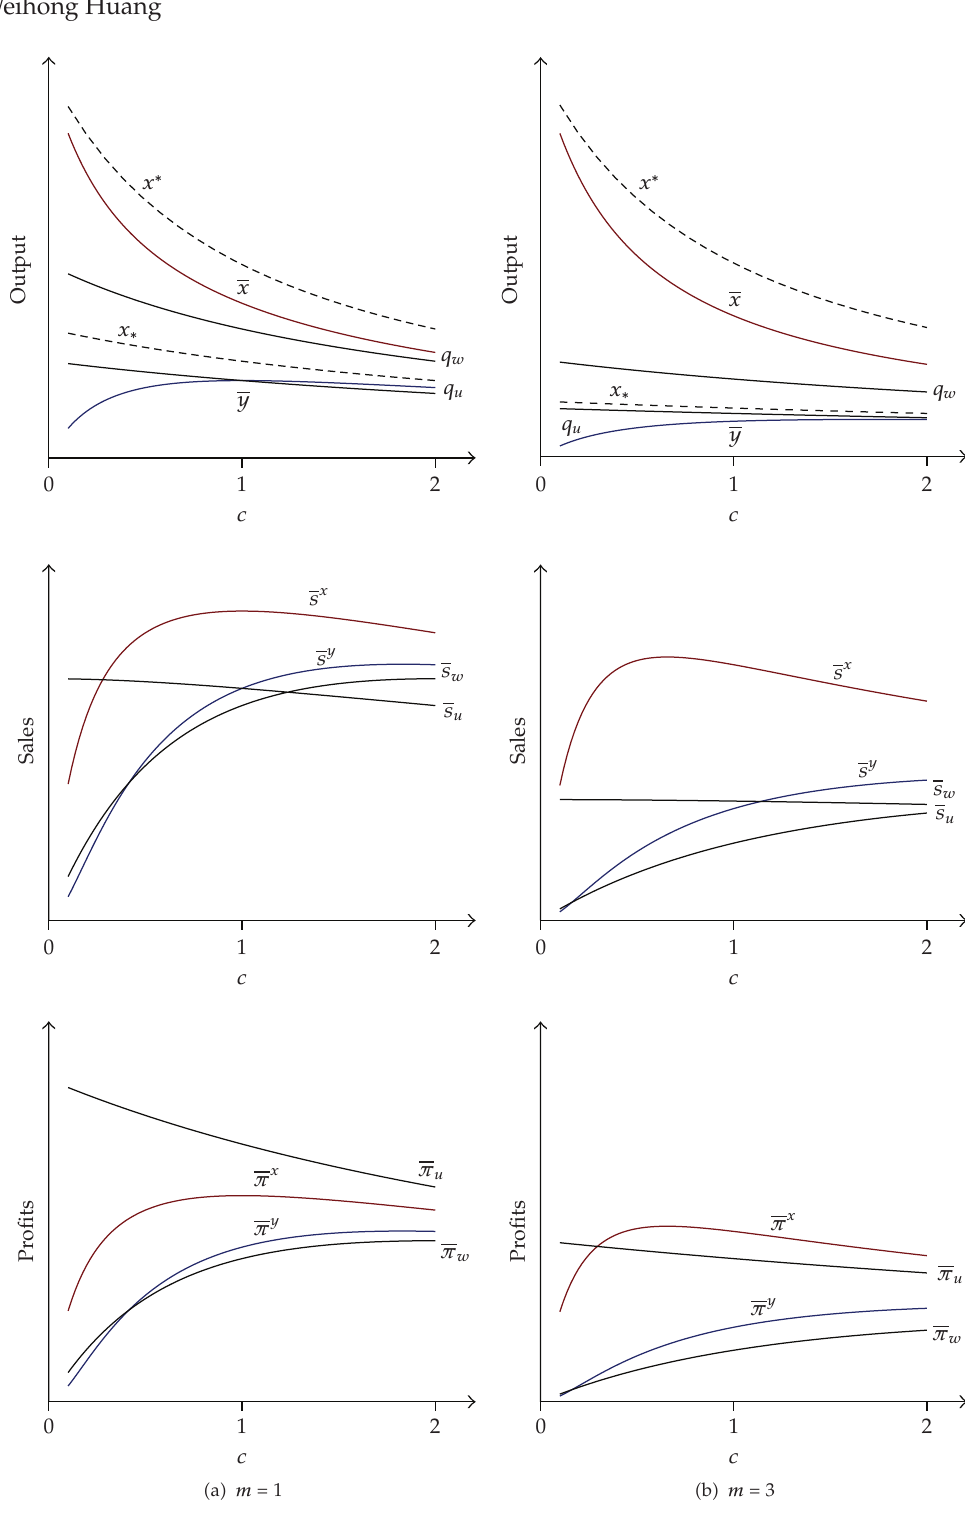
Figure 3: Critical outputs and performance